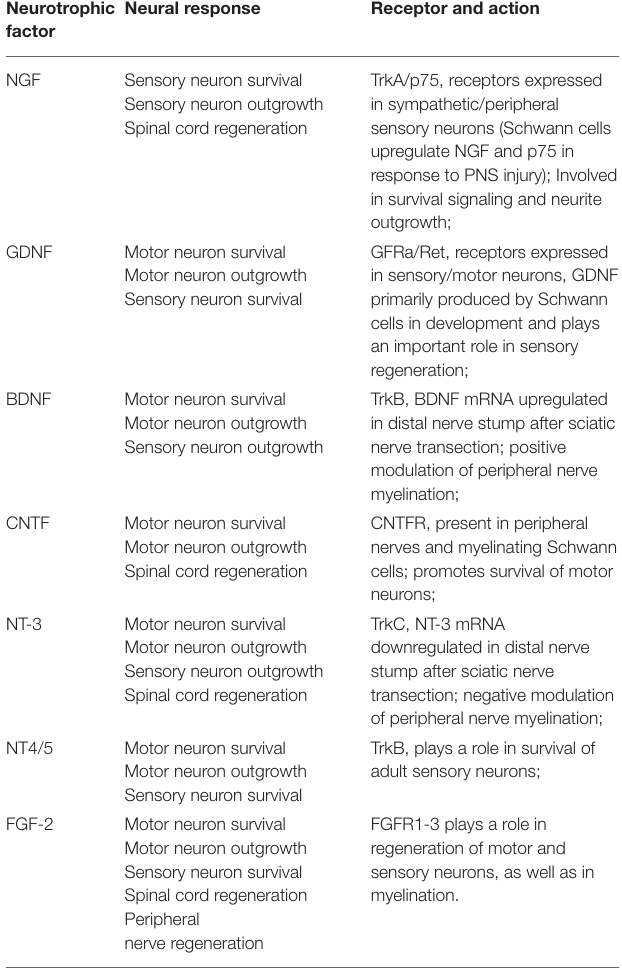
TABLE 1 | The use of GFs and their effect on CNS and PNS (Terenghi, 1999). Neurotrophic